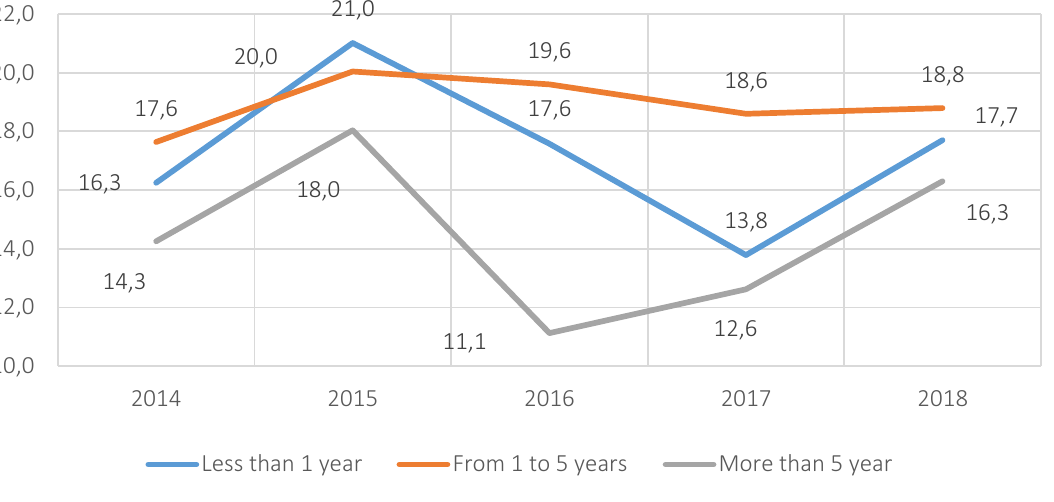
Figure 6. Interest rates for new loans in UAH for non-financial corporations by terms for 2014–2018,